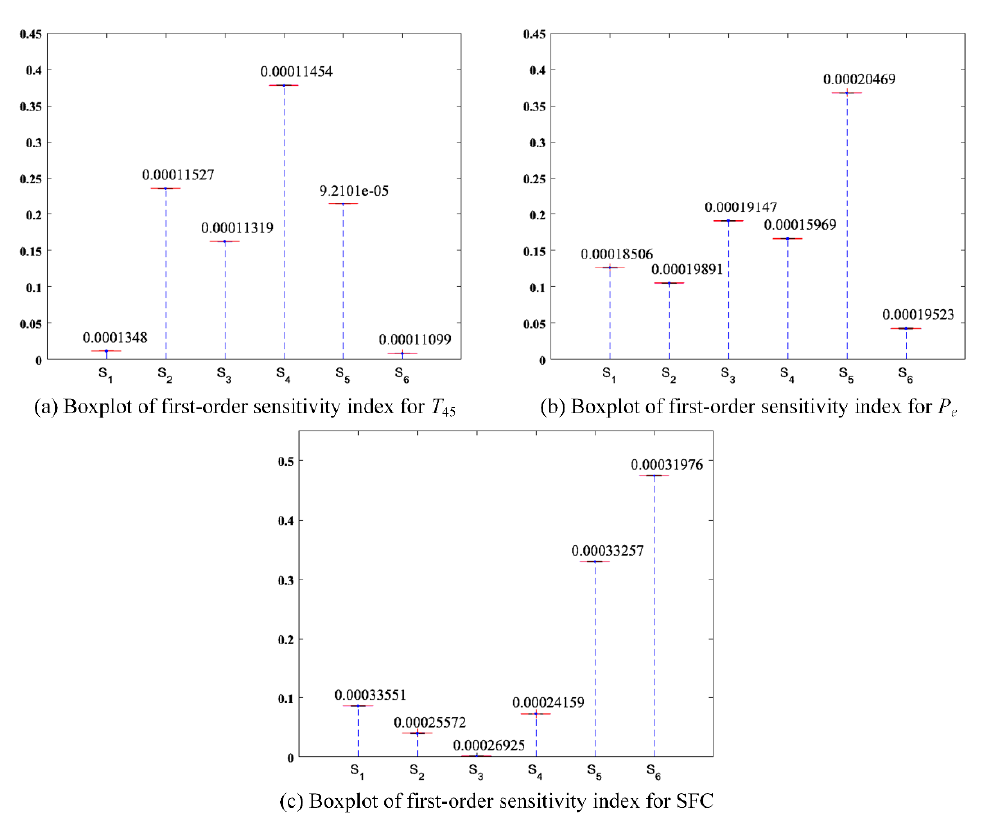
Figure 6. ( a ) The boxplot of first-order sensitivity index for T 45 ; ( b ) the boxplot of first-order sensitivity index for P e ; ( c ) the boxplot of first-order sensitivity index for SFC (the value above each boxplot represents corresponding the interquartile range).